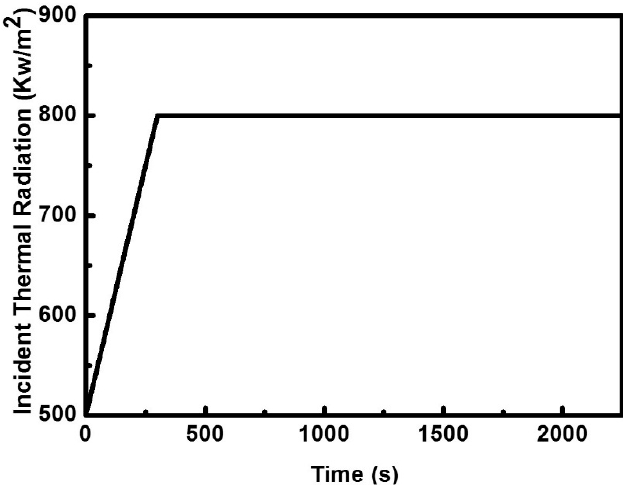
Figure 4. The heating profile for heat transfer test.